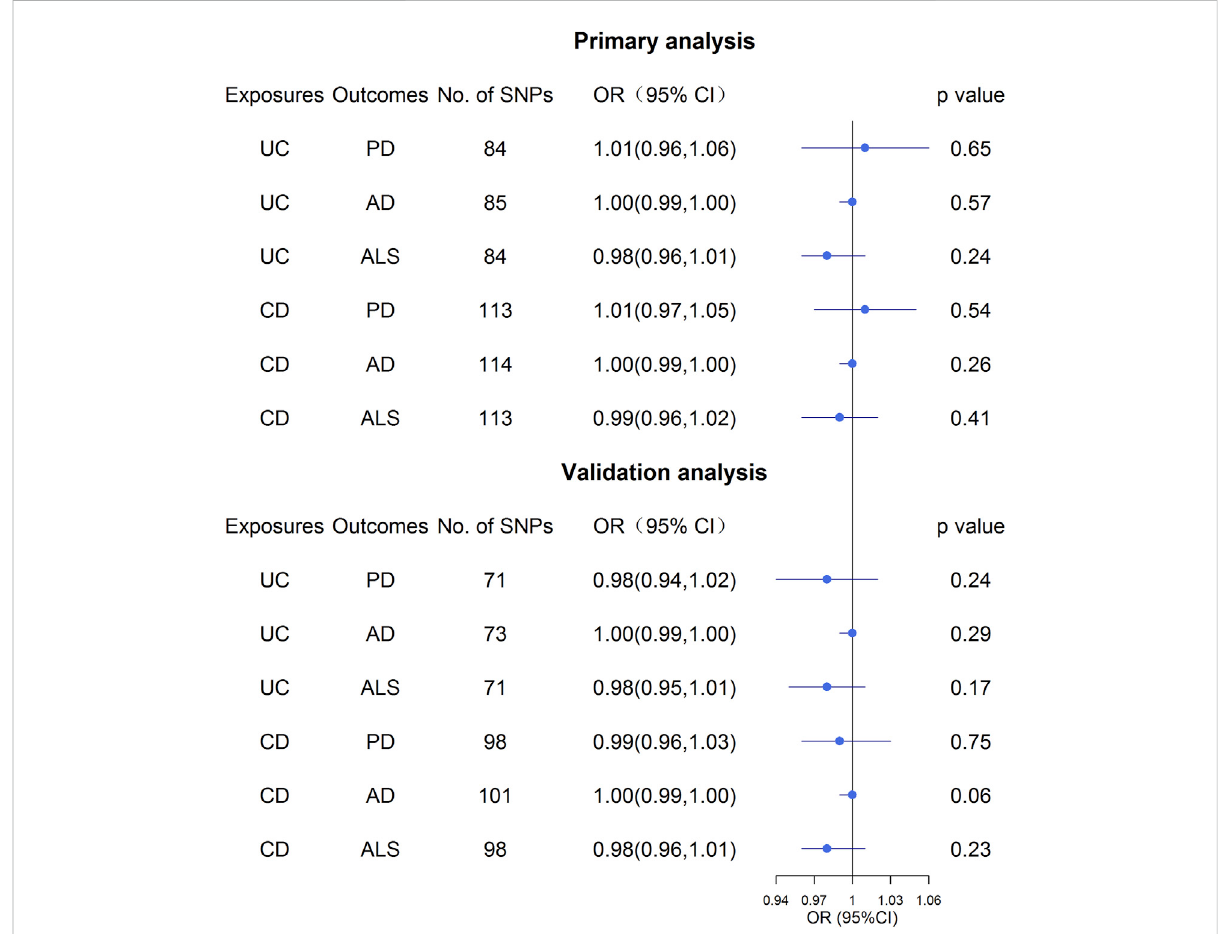
FIGURE 3 Effect estimates of UC and CD on NDs in the Mendelian randomization study. UC, ulcerative colitis; CD, Crohn ’ s disease; AD, Alzheimer ’ s Disease; PD, Parkinson ’ s Disease; ALS, Amyotrophic Lateral